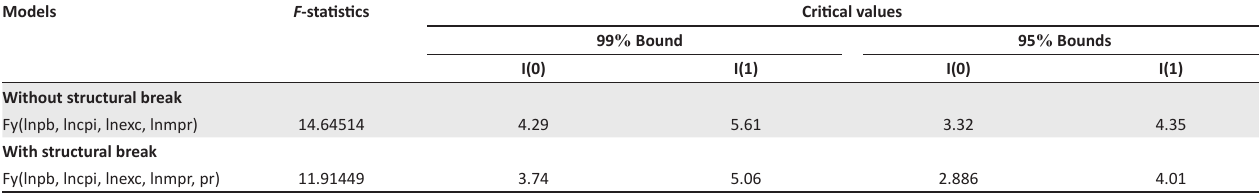
TABLE 2: Results from the auto-regressive distributed lag bounds test. Models